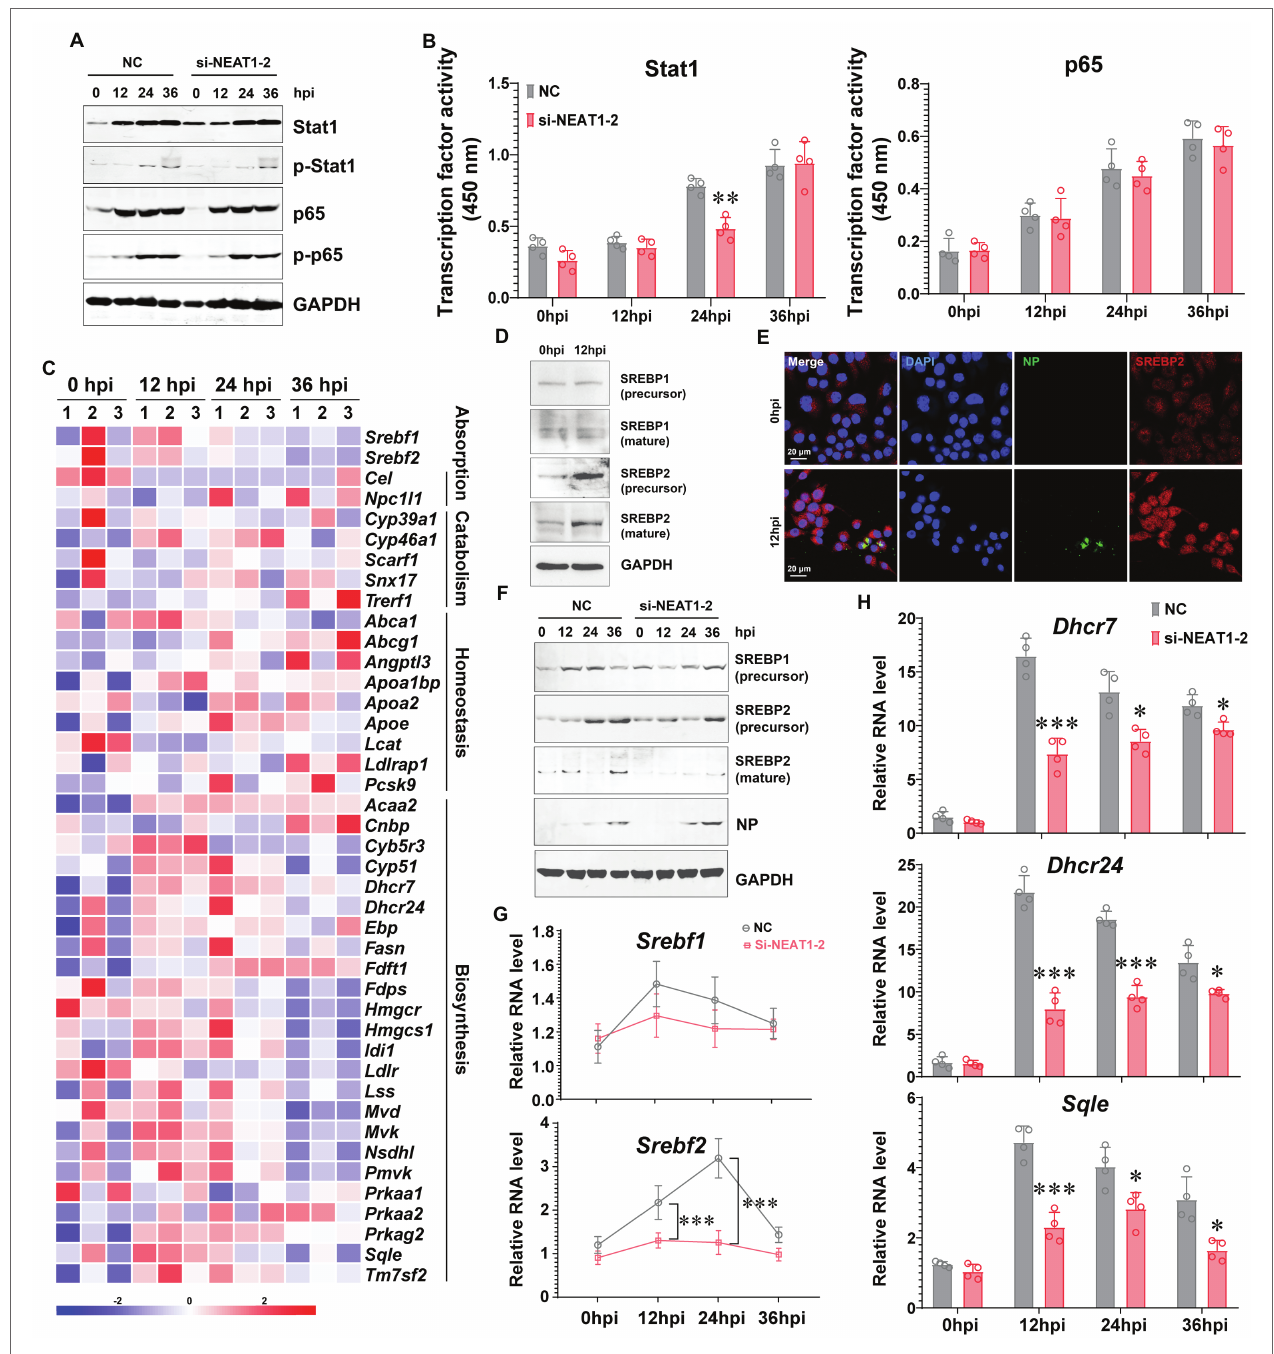
FIGURE 3 | Regulation of the SREBP2 Pathway by NEAT1-2 after HTNV Infection. (A) Immunoblot analysis of total and phosphorylated Stat1/p65 in hMDMs treated with RNAi (MOI = 5). (B) Detection of the transcriptional activity of Stat1 and p65 in hMDMs from (A) . (C) Heatmap of genes involved in cholesterol metabolism of mBMDMs from Figure 1A . (D) Immunoblot analysis of the indicated proteins in hMDMs at 12 hpi with an MOI of 5. (E) Immunofluorescence assays for SREBP2 and HTNV NP in hMDMs at 12 hpi with an MOI of 5. (F) Immunoblot analysis of the indicated proteins in hMDMs treated with RNAi (MOI = 5). (G) qRT- PCR analysis of Srebf1 and Srebf2 in hMDMs from (F) . (H) qRT-PCR analysis of the indicated genes associated with cholesterol synthesis from (F) . Data are shown as the mean ± SEM and are representative of three independent experiments. Each point represents a single sample ( n = 4 in each group). Analysis was